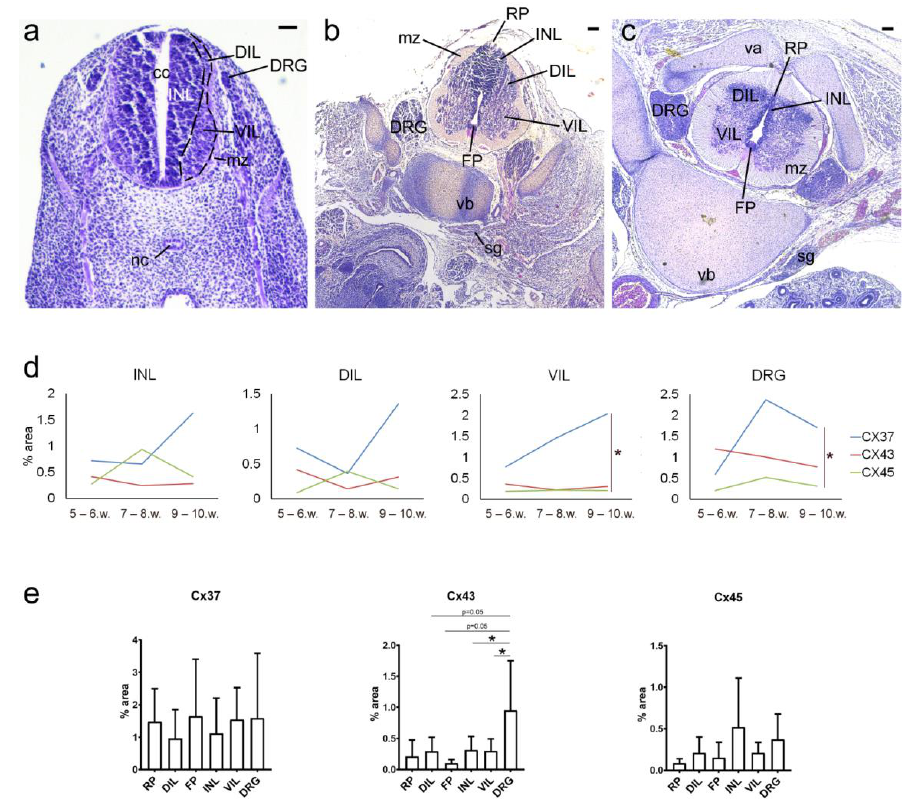
Figure 1. Hematoxylin-eosin staining of developing human spinal cord (SC) and ganglia and analysis of di ff erent connexins (Cxs) expression. Photomicrographs of sections through the thoracic segment of the human SC in ( a ) 5 weeks (objective magnification—10 × ; scale bar = 80 µ m), ( b ) 6.5 weeks, and ( c ) 10 week-old human conceptuses (both objective magnification—4 × ; scale bars = 200 µ m). DRG—dorsal root ganglion; INL—inner layer; DIL—dorsal intermediate zone; VIL—ventral intermediate zone; mz—marginal zone; cc—central canal; RP—roof plate; FP—floor plate; nc—notochord; sg—sympathetic ganglion; vb—vertebral body; va—vertebral arch. ( d ) Timeline of expression of di ff erent Cxs in di ff erent areas of the SC and DRG. ( e ) Expression of Cx37, Cx43, and Cx45 in di ff erent areas of the SC (for all samples). * p < 0.05 between indicated Cxs /